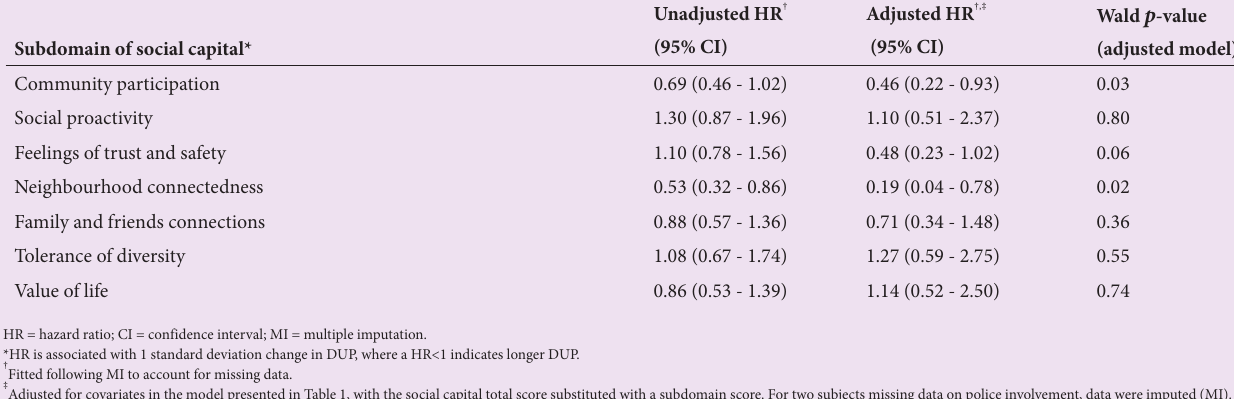
Table 2. Survival analysis with subdomains of social capital fitted in final model Subdomain of social